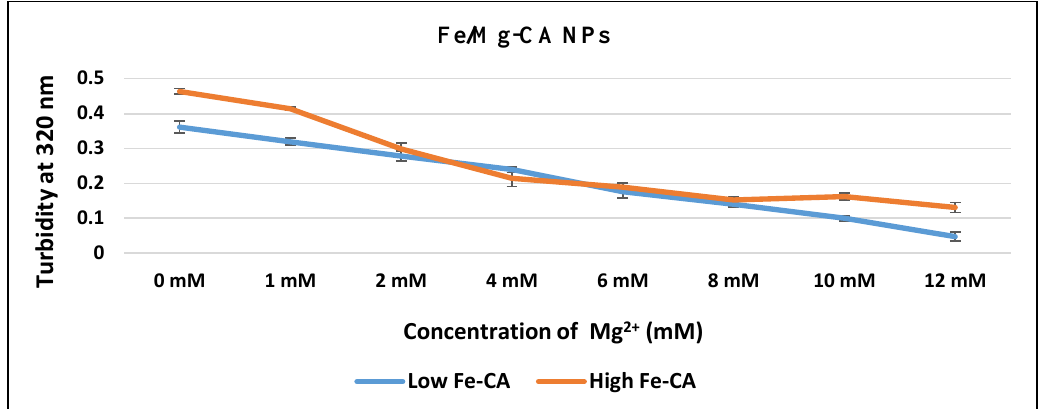
Figure 1. Turbidity measurement at 320 nm of Fe/Mg-carbonate apatite (Fe/Mg-CA) nanoparticles (NPs) formed by mixing increasing concentrations of exogenous Mg 2+ (0, 2, 4, 6, 8 and 10 mM) in a fixed concentration of exogenous Ca 2+ (4 mM Ca 2+ ) and two different (low and high) concentrations of Fe 3+ , 1 µM and 5 µM in 1 mL Dulbecco’s modified eagle medium (DMEM), followed by incubation at 37 °C for 30 min and supplementation with 10% fetal bovine serum (FBS).